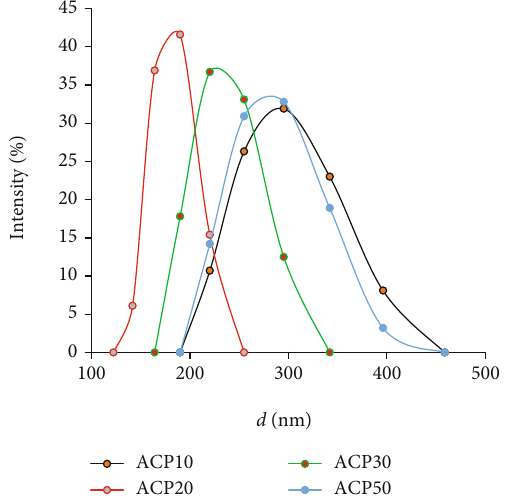
Figure 4: Size distribution diagrams of the AGN/CS/PP nanoparticles.